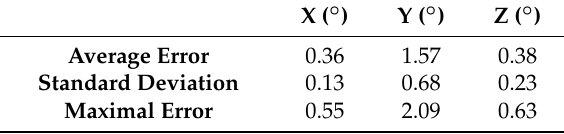
Figure 6. Test setup on the Kuka ® welding robot for accuracy validation of the proposed head tracking system. Table 1. Accuracy validation for the proposed device.